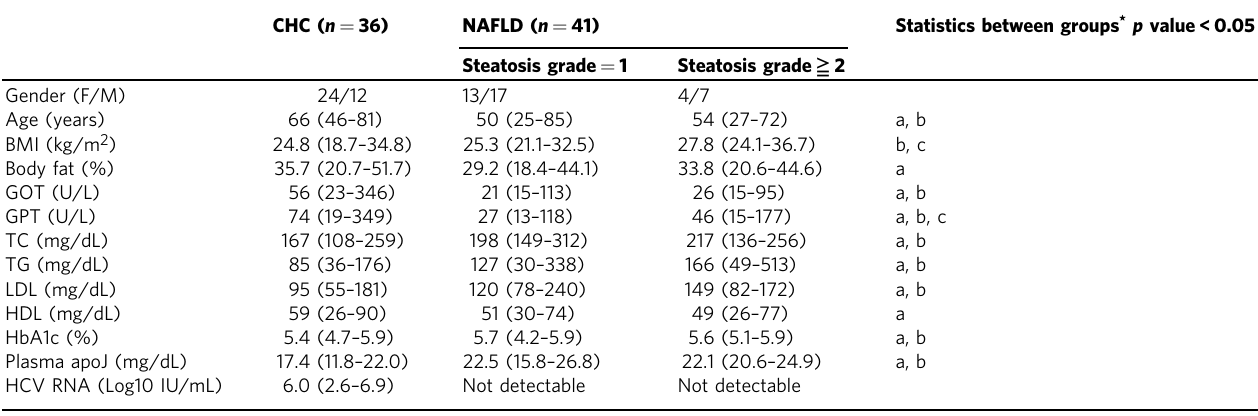
Table 2 Patient demographics of the enrolled CHC and NAFLD patient groups in the